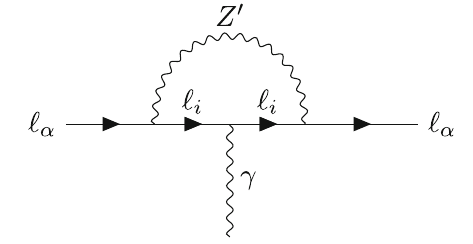
Fig. 3 New contributions to the anomalous magnetic moment of charged leptons, a (cid:4) α ; notice that the internal lepton flavour is neces- sarily different from the external one ( (cid:4) i (cid:6)= (cid:4) α )